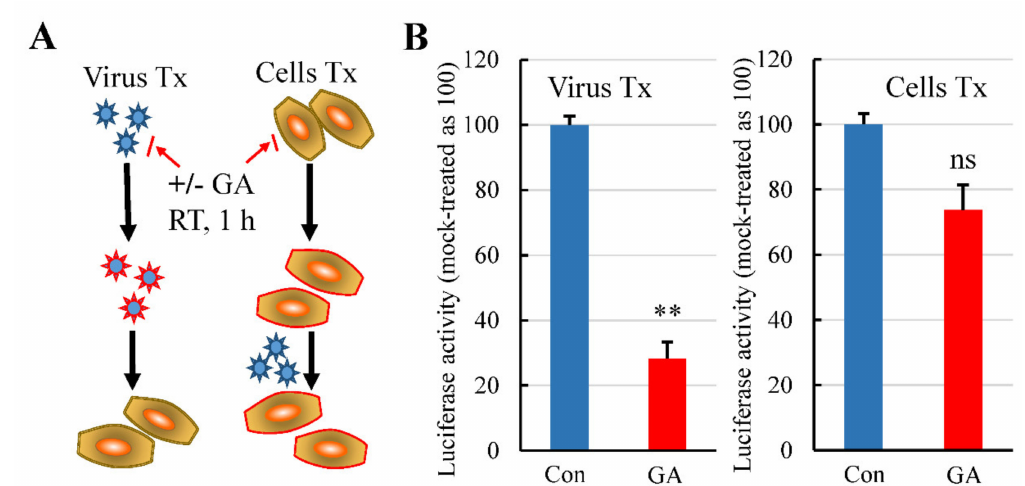
Figure 3. Pretreatment of Lenti-S or host cells with GA on Lenti-S mediated luciferase gene delivery. ( A ) Diagram showing Lenti-S or host cells were treated (Tx) with 3 mM GA prior to the infection assay. Both Lenti-S and host cells were untreated or treated with 3 mM GA for 1 h. At the end, the GA-treated Lenti-S was 1:30 diluted and used to infect untreated host cells (final concentration of GA in the medium was approximately 0.1 mM). In parallel, the medium of the GA-treated cells was replaced with fresh medium without GA followed by infection of untreated Lenti-S. Luciferase activity was determined 24 h later. ( B ) GA effect on Lenti-S (Virus Tx) and on host cells (Cells Tx). Luciferase activity was expressed as a percentage of untreated controls. Data are mean ± SD of duplicate wells from 2 experiments. ns, no significance; **, p < 0.01 by Student’s t